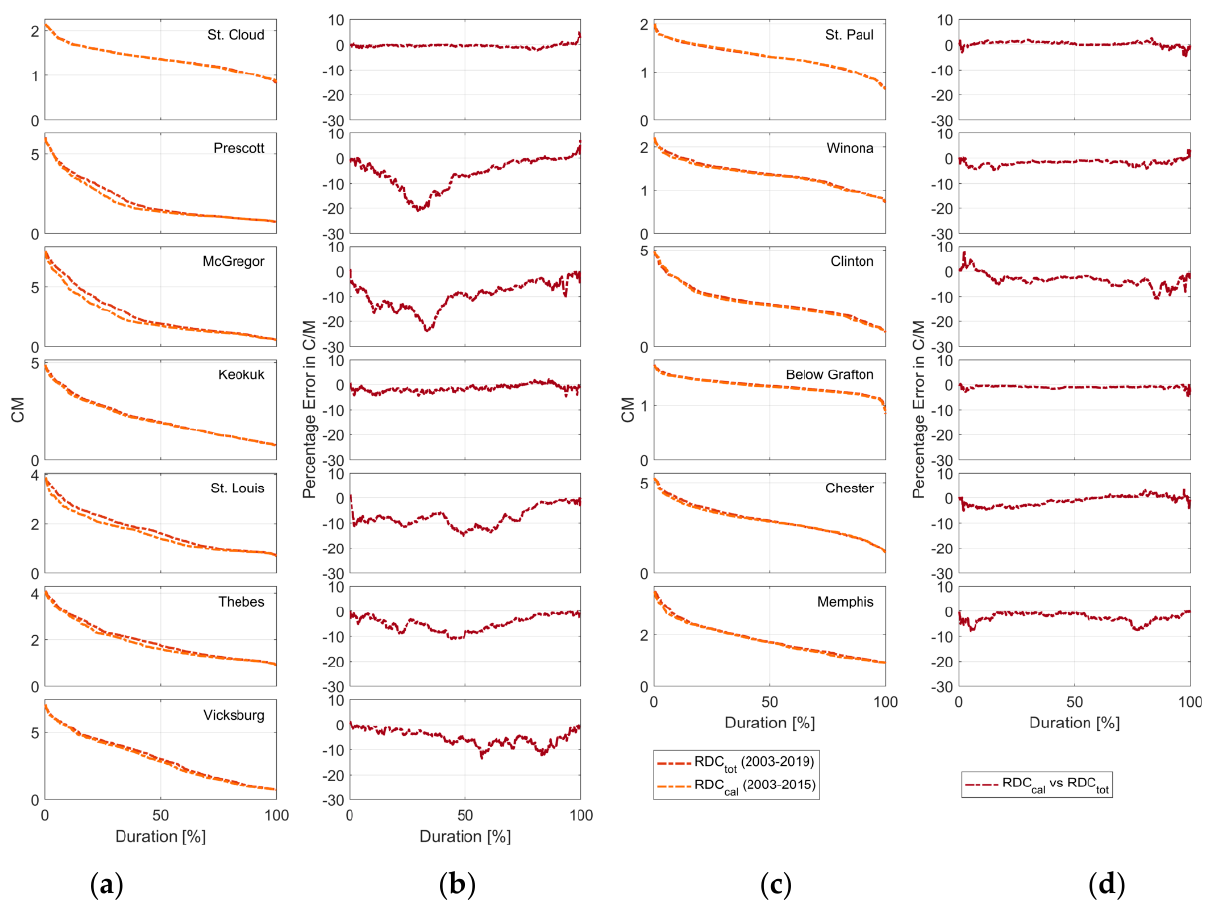
Figure 5. ( a , c ) show reflectance ratio duration curves (RDCs) calculated for (i) the entire period (tot), from 2003 to 2019, and (ii) for the selected calibration period (cal), from 2003 to 2015. ( b , d ) columns show differences in reflectance ratio C/M between the RDCs built considering the calibration and the total period, for all the sites analyzed.